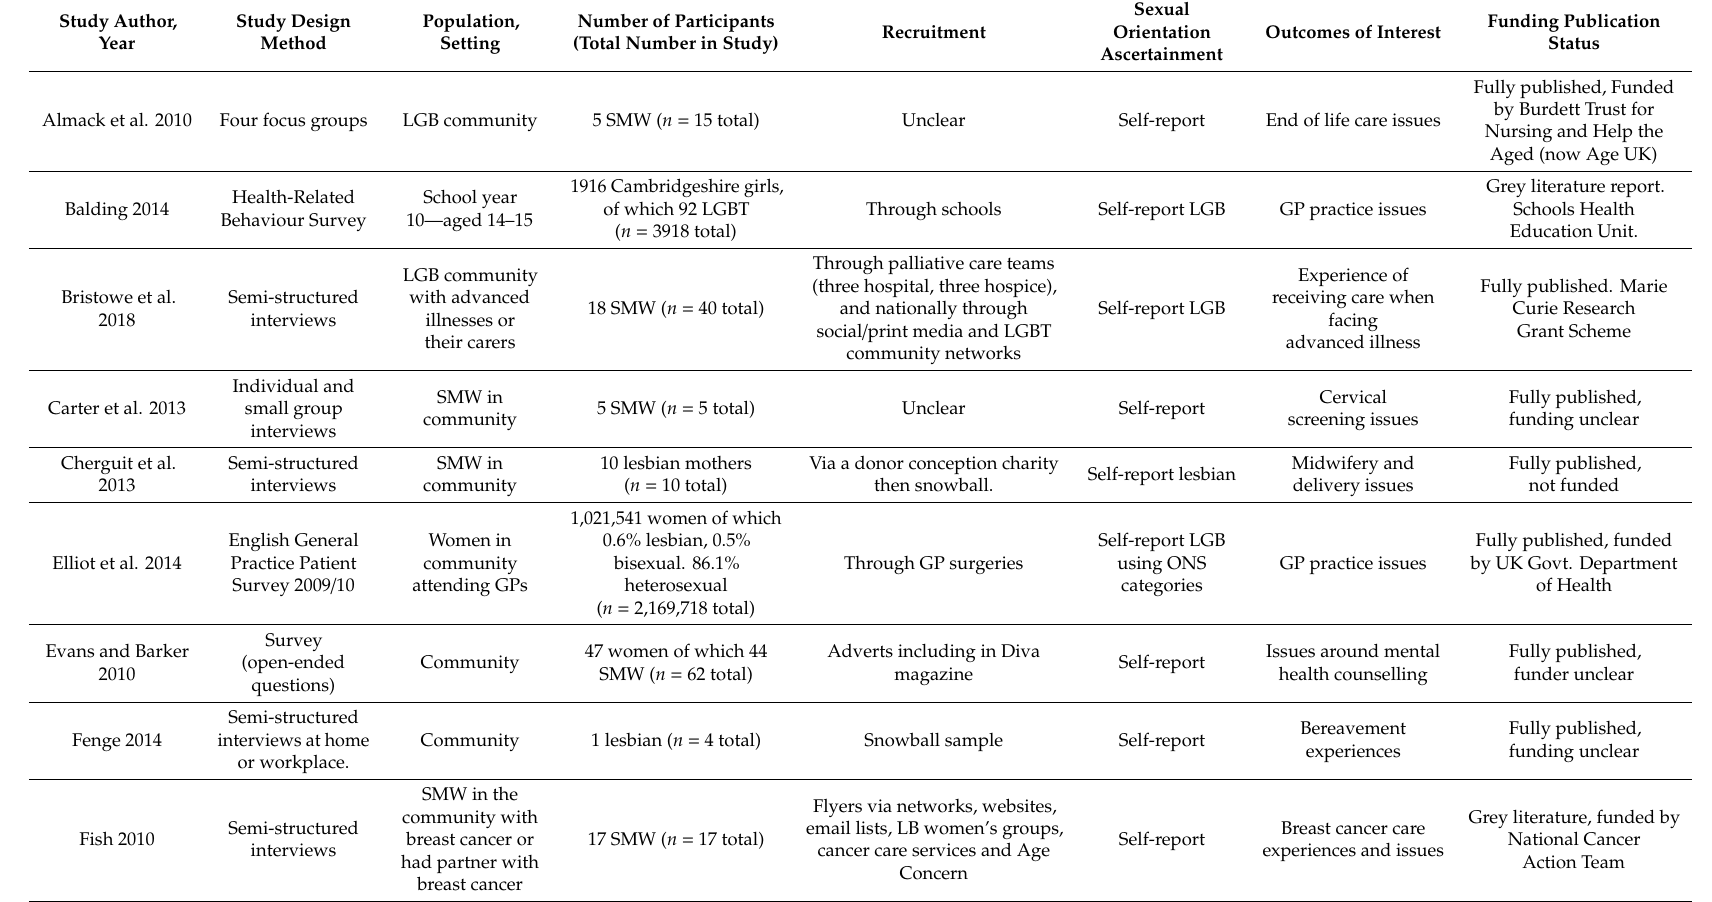
Table 1. Characteristics of included